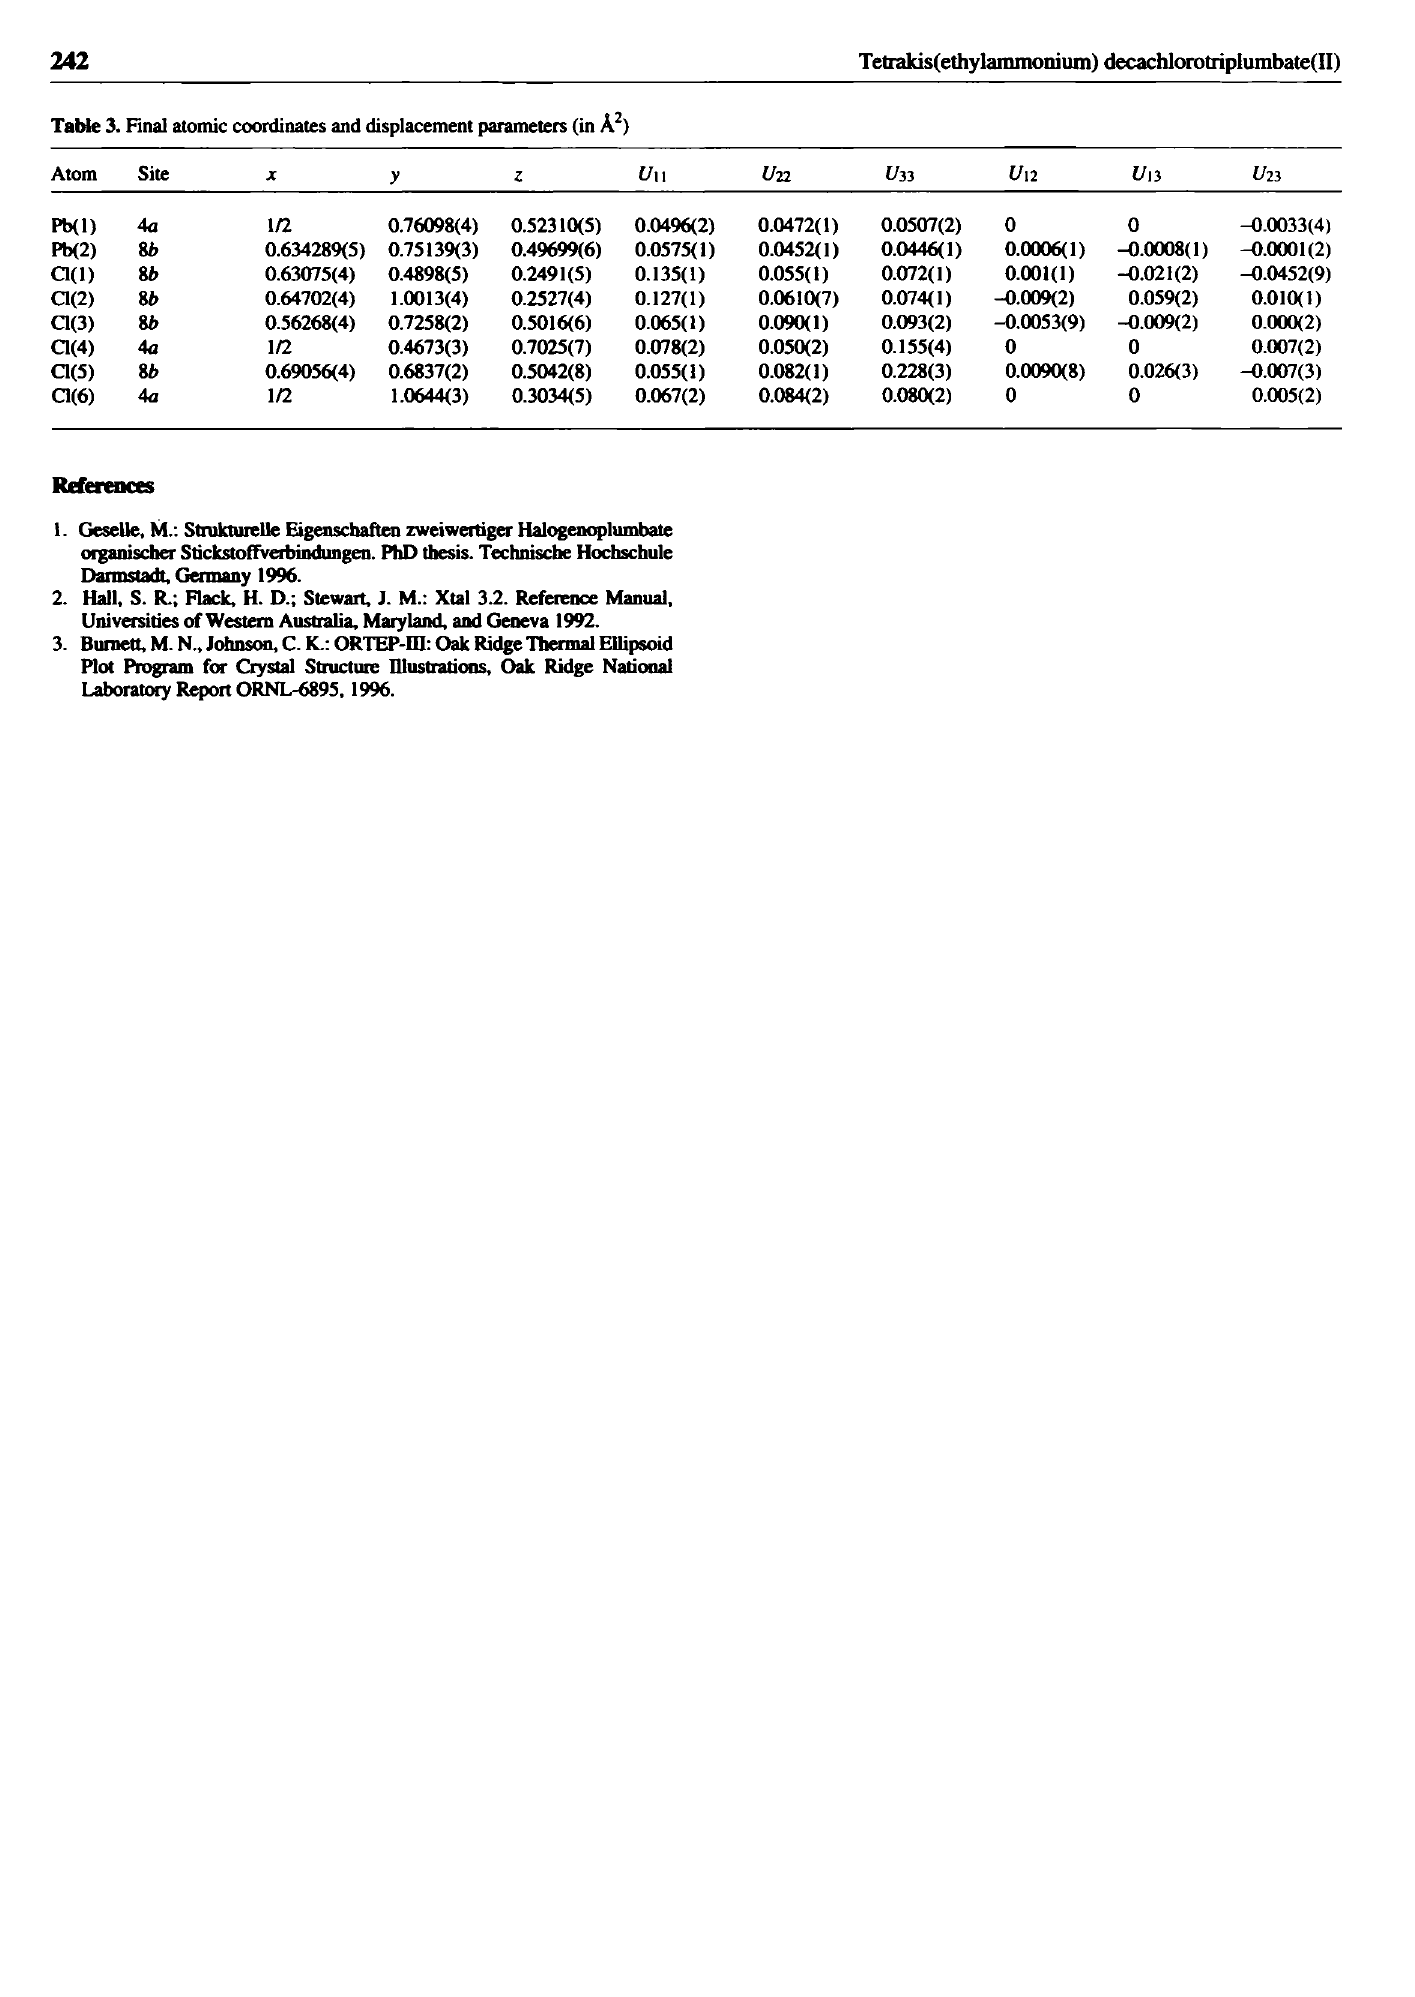
Table 3. Final atomic coordinates and displacement parameters (in Â 2 )